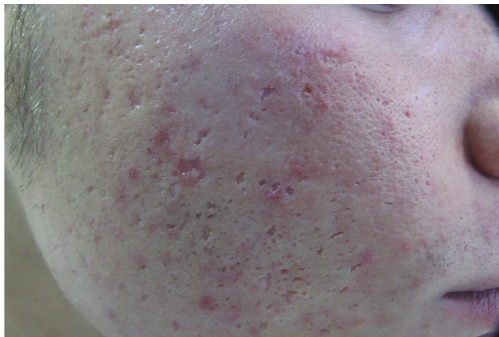
Figure 4: TCA Cross: patient before the treatment.